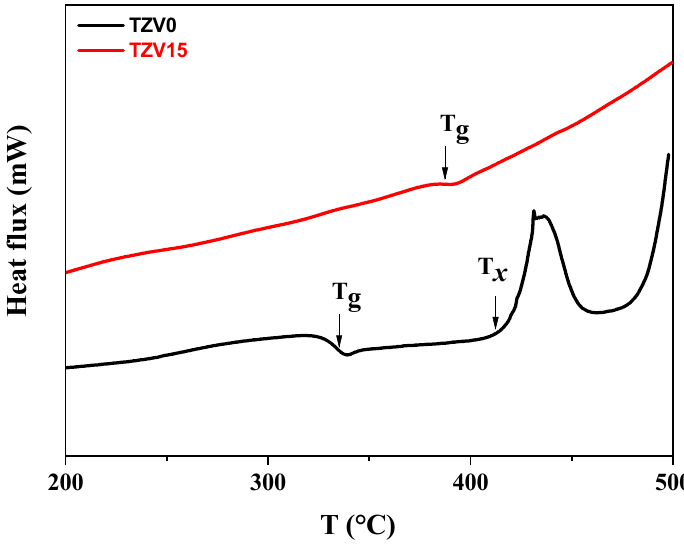
Figure 1. DSC curves of the as synthesized glasses.